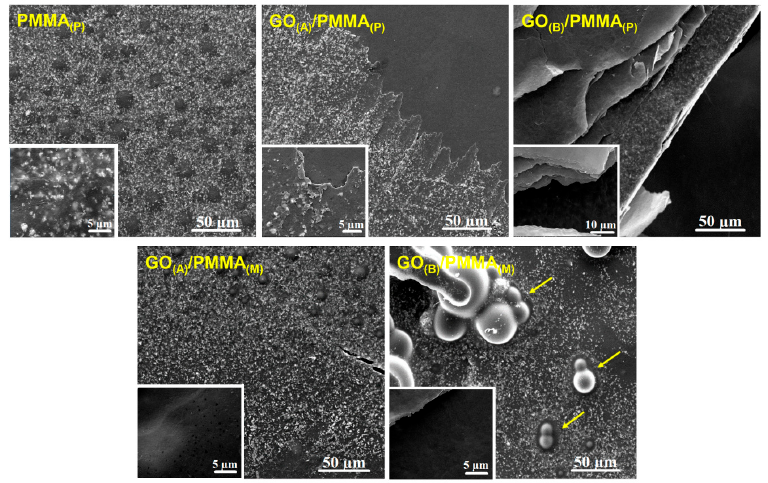
Figure 2. SEM micrographs presenting surface morphology of GO (A) / PMMA (P) , GO (B) / PMMA (P) , GO (A) / PMMA (M) , and GO (B) / PMMA (M) (arrows indicate discussed surface structures), as well as untreated PMMA, with high magnification images as the insets.